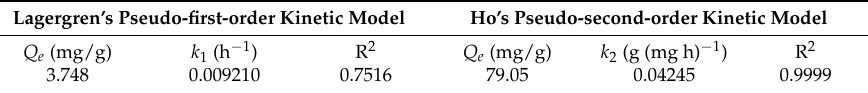
Table 1. Kinetic parameters for the loading of DOX by CDHA–MGO.